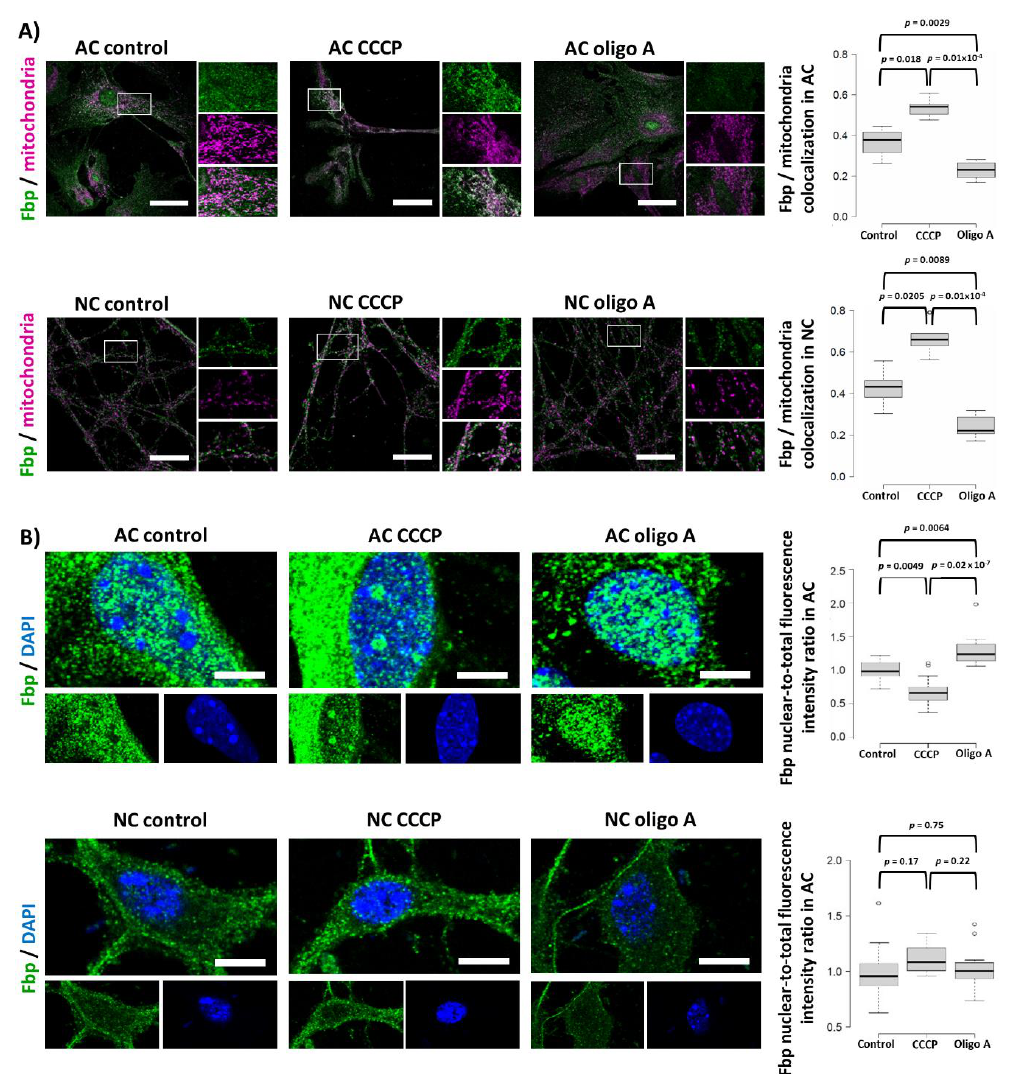
Figure 5. Mitochondrial membrane potential-dependent changes in Fbp2 subcellular localization in astrocytes and neurons. ( A ) Representative microscopic images of Fbp2–mitochondria colocalization and( B )nucleo-cytoplasmicdistributionoftheenzymetogetherwithquantitativeanalysisoftheintensity of Fbp2-related fluorescent signal in these compartments under di ff erent treatments are